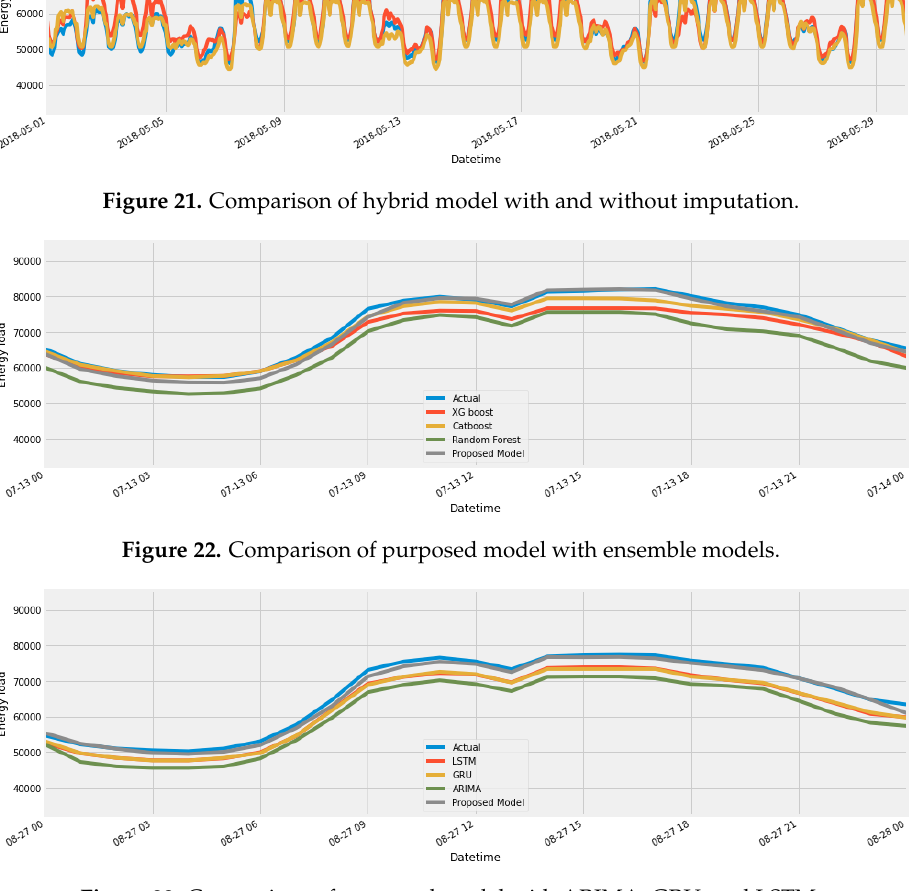
Figure 23. Comparison of purposed model with ARIMA, GRU, and